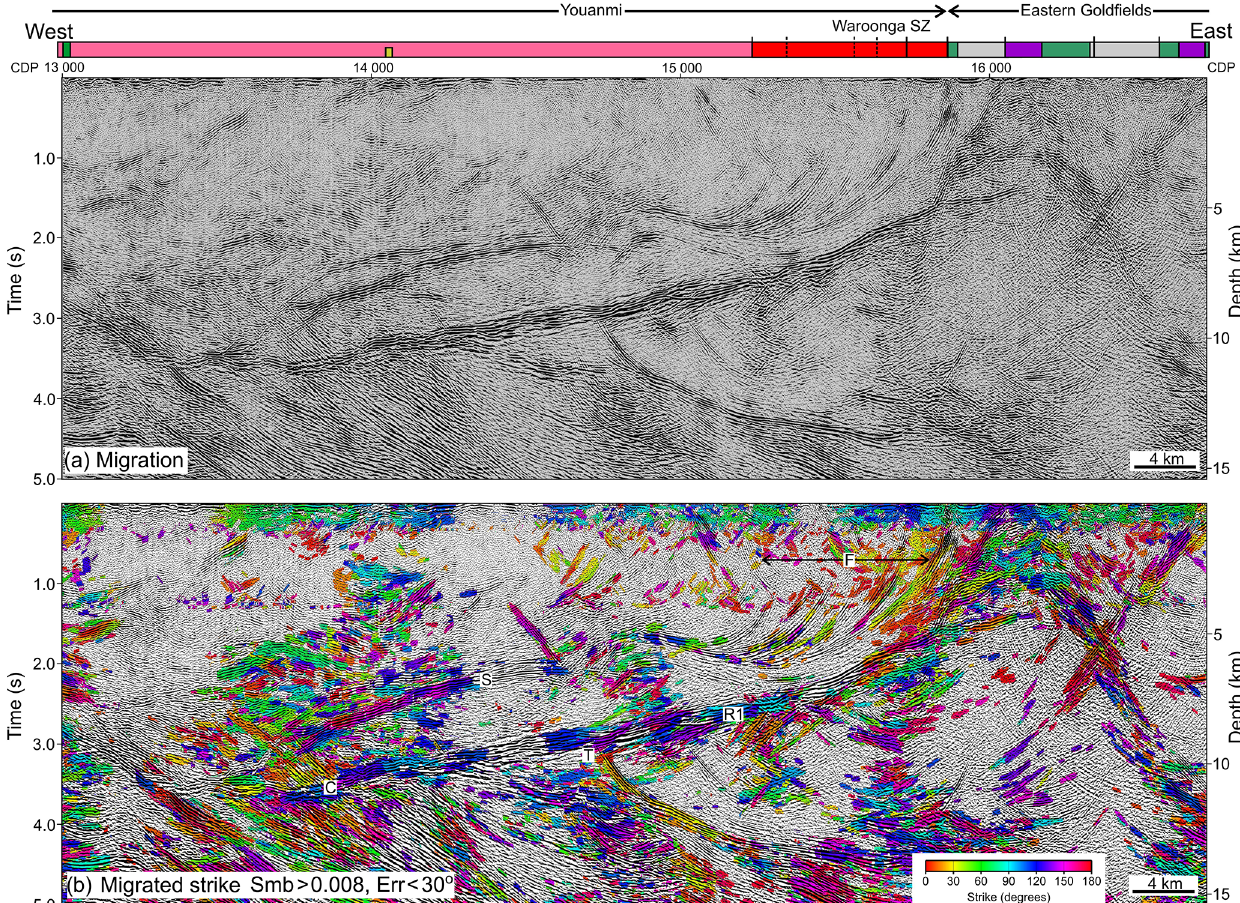
Figure 4. Section of line 10GA-YU2 across the boundary between the Youanmi Terrane and the Eastern Goldfields Superterrane: (a) F-K migration, (b) migrated reflector strike superimposed on F-K migration; only arrivals with semblance greater than 0.008 and strike estimation error less than 30 ◦ are included. Dark pink: granitoid rocks; red: tonalitic gneiss; green: mafic volcanic rocks; purple: ultramafic volcanic rocks; grey: sedimentary rocks; yellow: Proterozoic